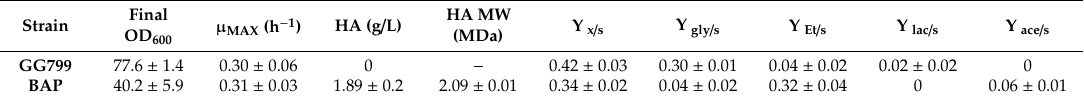
Table 3. Final OD 600 , Growth Rate µ MAX (h − 1 ), Hyaluronic Acid production (g/l), Hyaluronic Acid Molecular Weight (MDa) and Yields of biomass (x), glycerol (gly), ethanol (et), lactate (lac) and acetate (ace) for all strains constructed. The strains were grown in bioreactor. Values were obtained from biological triplicate.